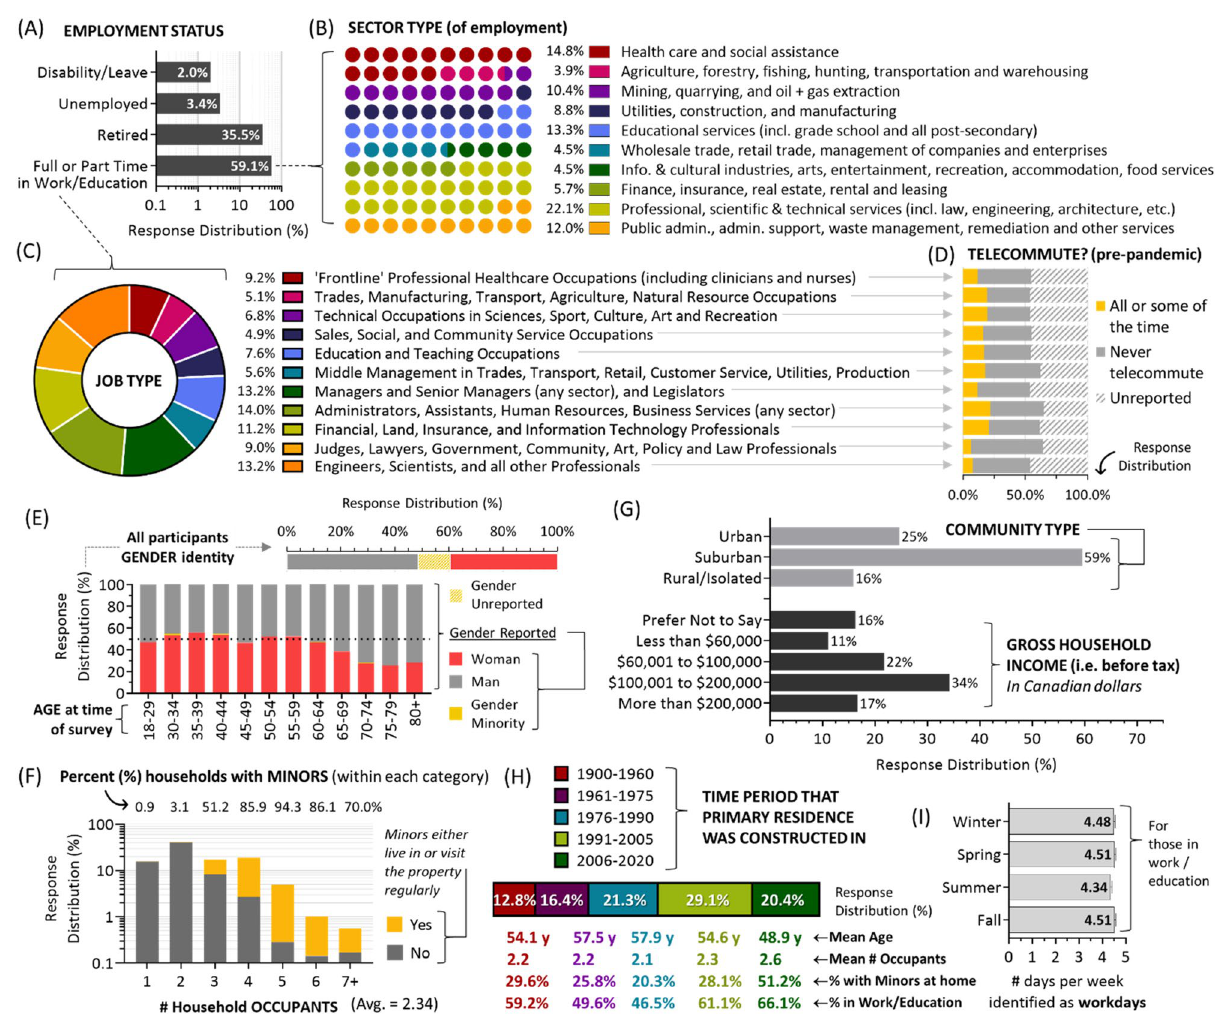
Figure 1. Demographic characteristics of the human activity pattern study cohort. Panel A . Study cohort by employment status. Panel B . Sector of employment for those in full or part time work, where each colour corresponds to the indicated sector, and each circle represents 1% of the total cohort. Panel C : A pie chart showing the distribution of the indicated job types for those in full or part time work. Panel D . Reported telecommuting during the pre-pandemic period for those in work, as a function of job type. Panel E . Top graph, the distribution of reported and unreported gender identities. Bottom graph, for those of known gender, distribution by age bracket. Panel F . Distribution by number of household occupants, with yellow bars indicating percentage where minors either live full time or visit regularly. Panel G . Breakdown by community identity and gross household income bracket. Panel H . Distribution of primary residences by year of construction bracket, coupled with geometric mean age, occupant number, % minors at home and % in work or education by grouping. Panel I . Number of days identified by those in full or part time employment (or education) as workdays, by season. Figures were prepared using Excel and GraphPad Prism 9.1.1 (225) (www. graph pad.